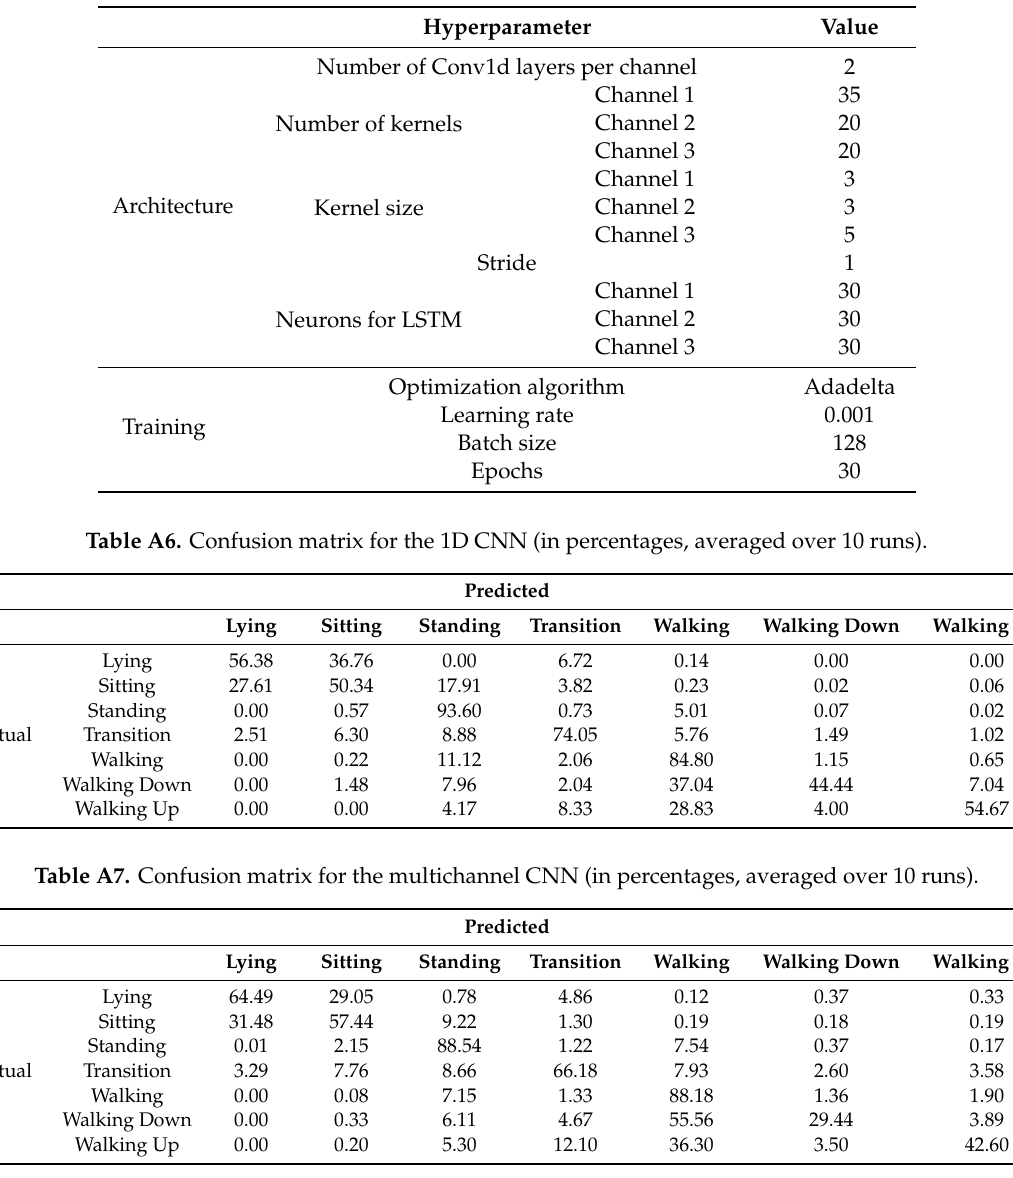
Table A5. Hyperparameter values for the multichannel CNN-LSTM.